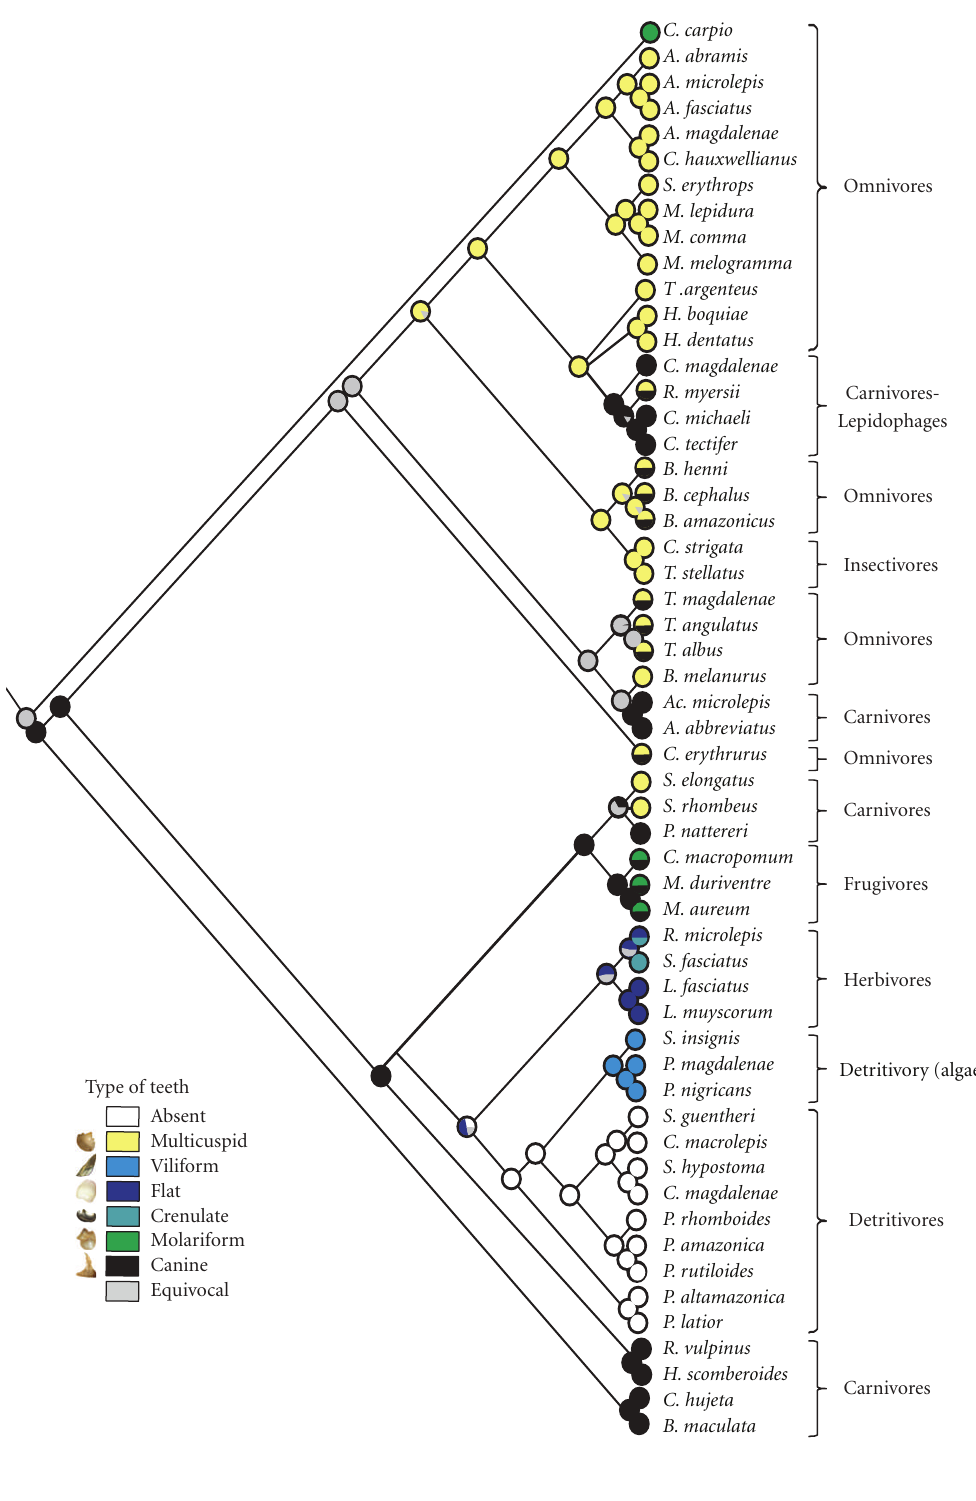
Figure 10: Reconstruction of teeth type shown on consensus tree in 800 trees with Bayesian inference. Pie charts at major nodes show posterior probabilities from stochastic analysis of ancestral state reconstructions assuming that character-state evolution is